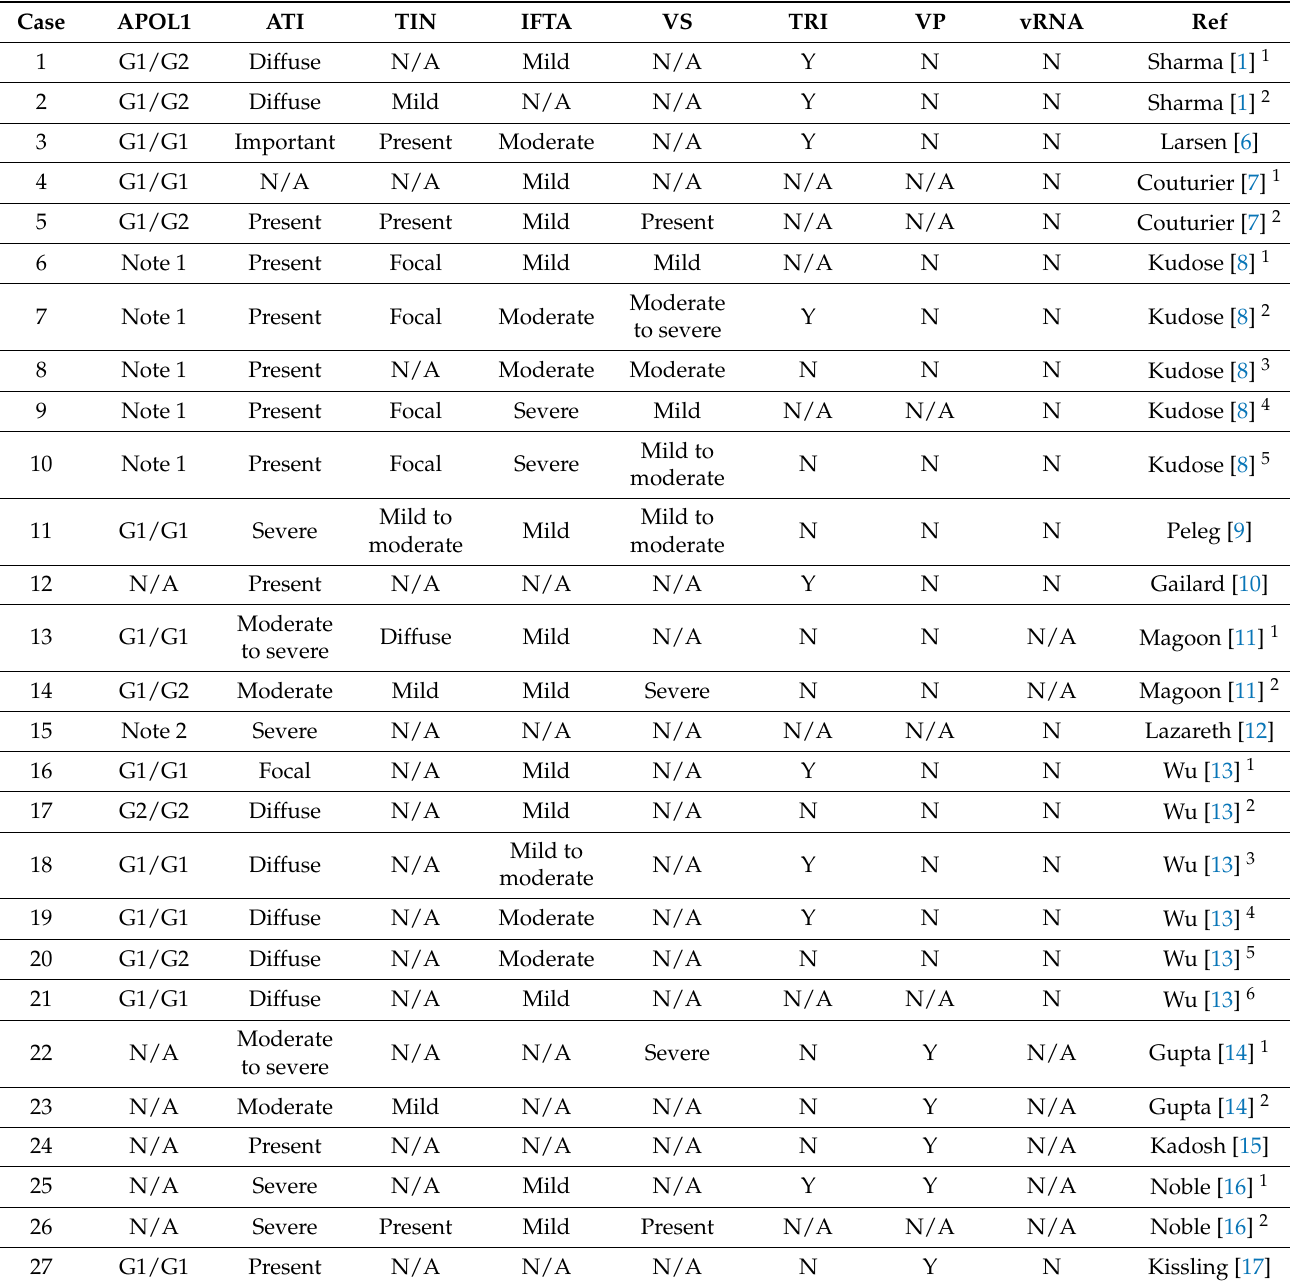
Table 2. Pathologic findings in published patients with collapsing segmental and focal glomerulosclerosis during COVID-19